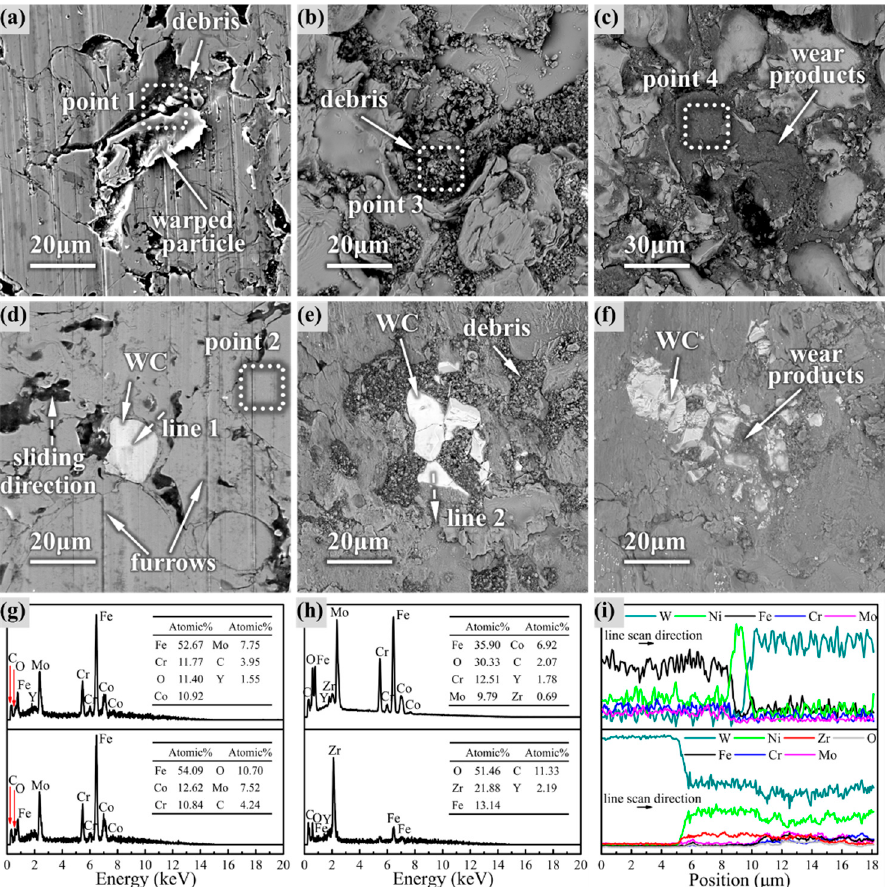
Figure 6. Worn morphology and EDS analysis of the coating surface after different wear times: ( a – c ) amorphous coating after 5, 15, 25 min of wear; ( d – f ) composite coating after 5, 15, 25 min of wear; ( g ) EDS after 5 min of wear at point 1 and point 2; ( h ) debris EDS after 10 min of wear at point 3, and wear products EDS after 15 min of wear at point 4; ( i ) elemental line scanning in the direction of line 1 after 5 min of wear and in the direction of line 2 after 10 min of wear.